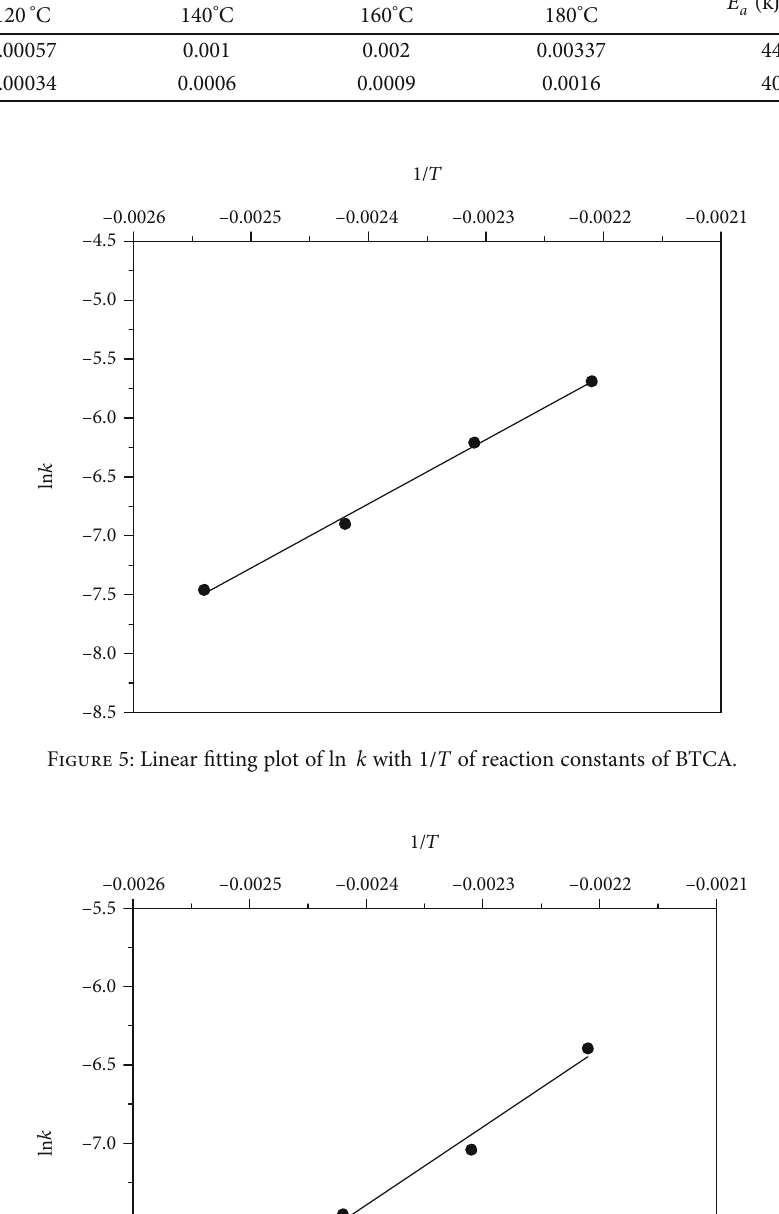
Table 1: Kinetics data of esteri fi cation during the curing process for both the BTCA and BTCA/CA system. k